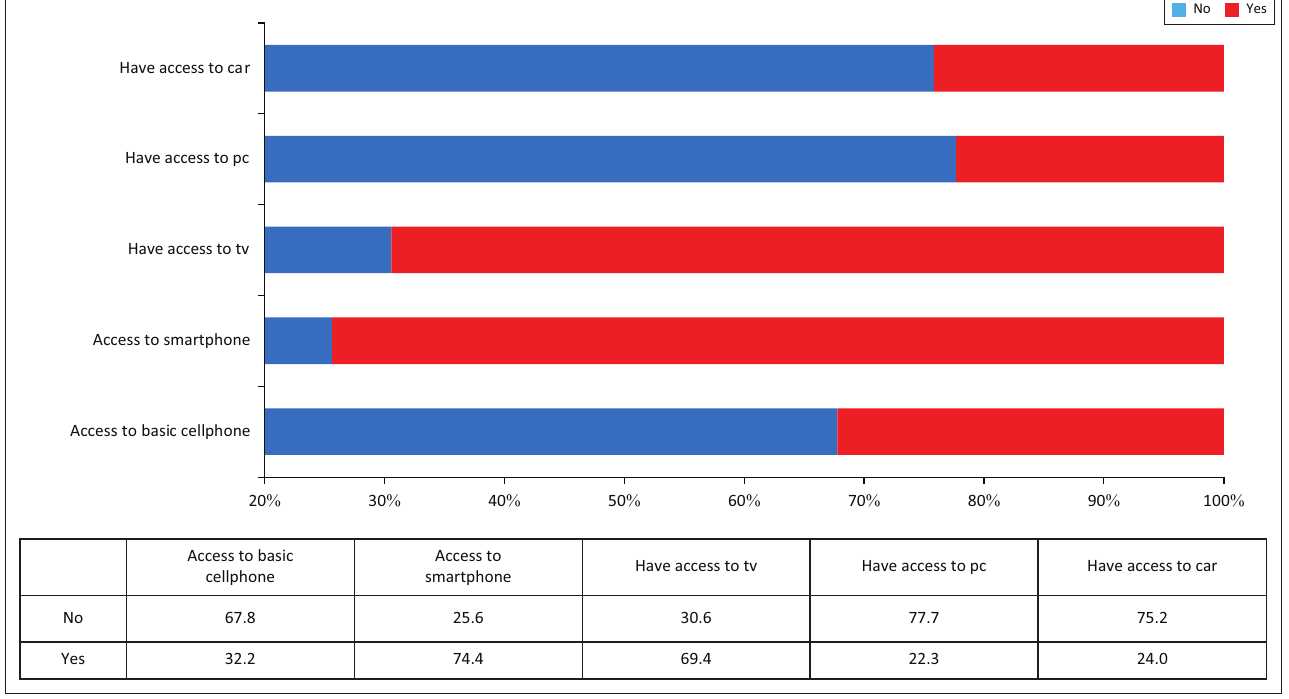
FIGURE 2: Access to cars, radios, televisions and